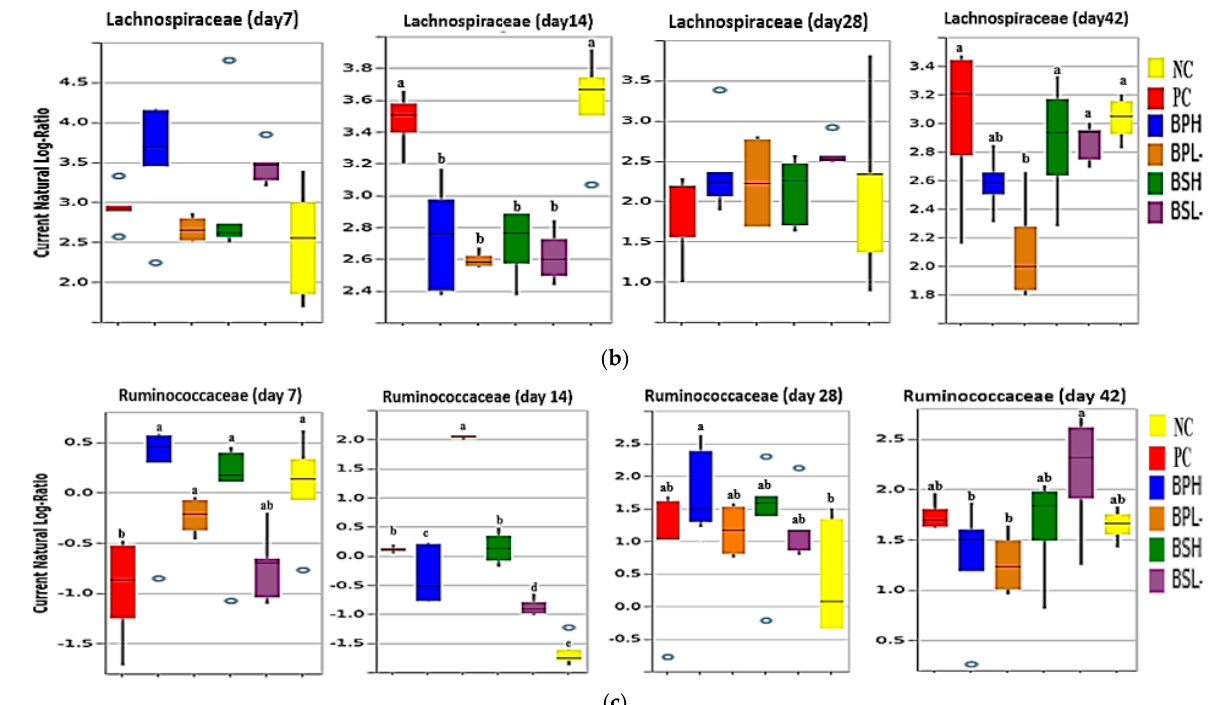
Figure 1. Plots showing relative frequency of the microbial taxonomic composition of different phyla ( a ) and the microbial relative abundance of the family Lachnospiraceae ( b ) and the family Ruminococcaceae ( c ) in response to treatments at 7, 14, 28, and 42 days of age. The abundance of Lachnospiraceae and Ruminococcaceae was calculated as the natural log-ratios. The Ruminococcus was used as a reference frame in the log ratio test. Chickens were fed dietary treatments as described in Table 1. Boxes in panels b and c show the medians/quartiles of treatment samples, and the error bars extend to the most extreme values within the 1.5 interquartile ranges ( n = 4 or 5). a–e Different letters mean significant differences among groups ( p < 0.05).